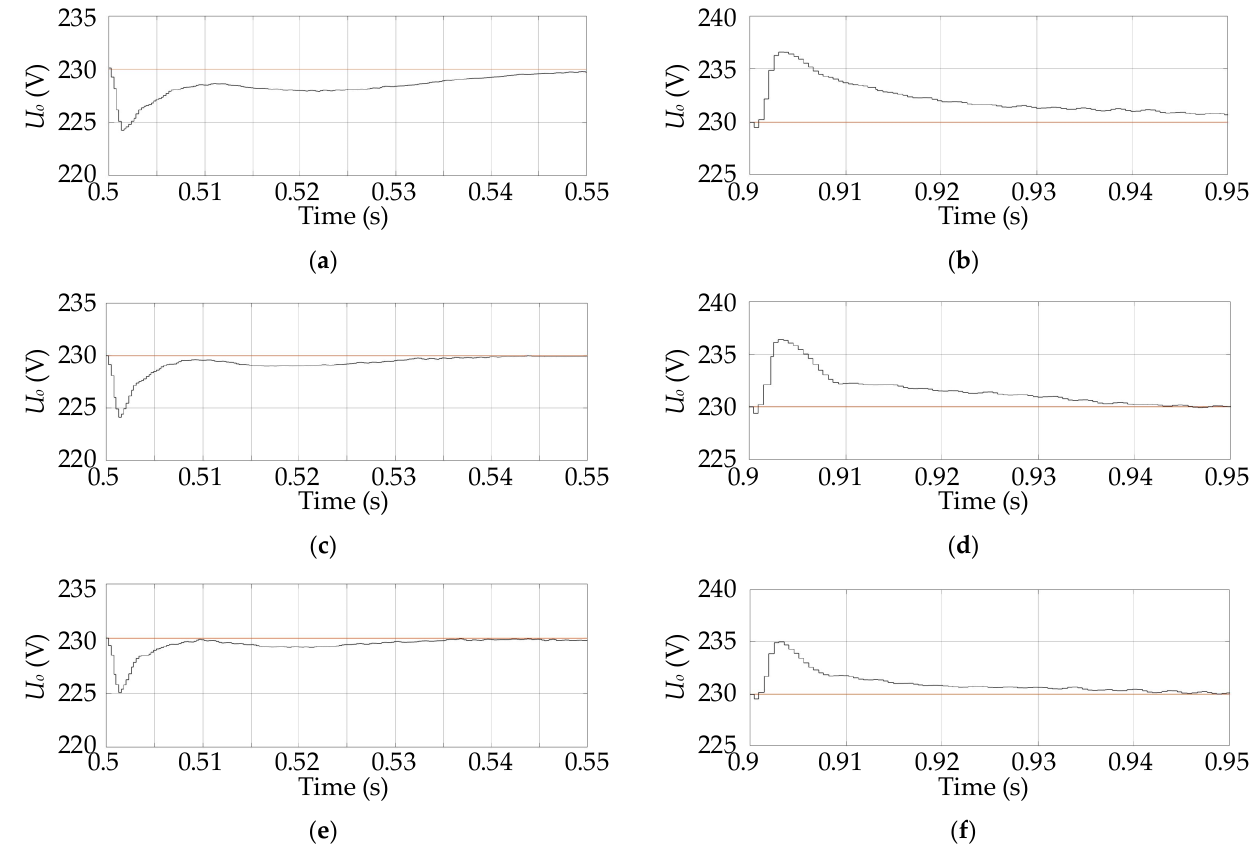
Figure 15. Dynamic performance of a power generation system at 9615 r/min: ( a ) suddenly loaded with a PI controller; ( b ) suddenly unloaded with a PI controller; ( c ) suddenly loaded with a fuzzy PI controller; ( d ) suddenly unloaded with a fuzzy PI controller; ( e ) suddenly loaded with a dual fuzzy PI controller; ( f ) suddenly unloaded with a dual fuzzy PI controller.